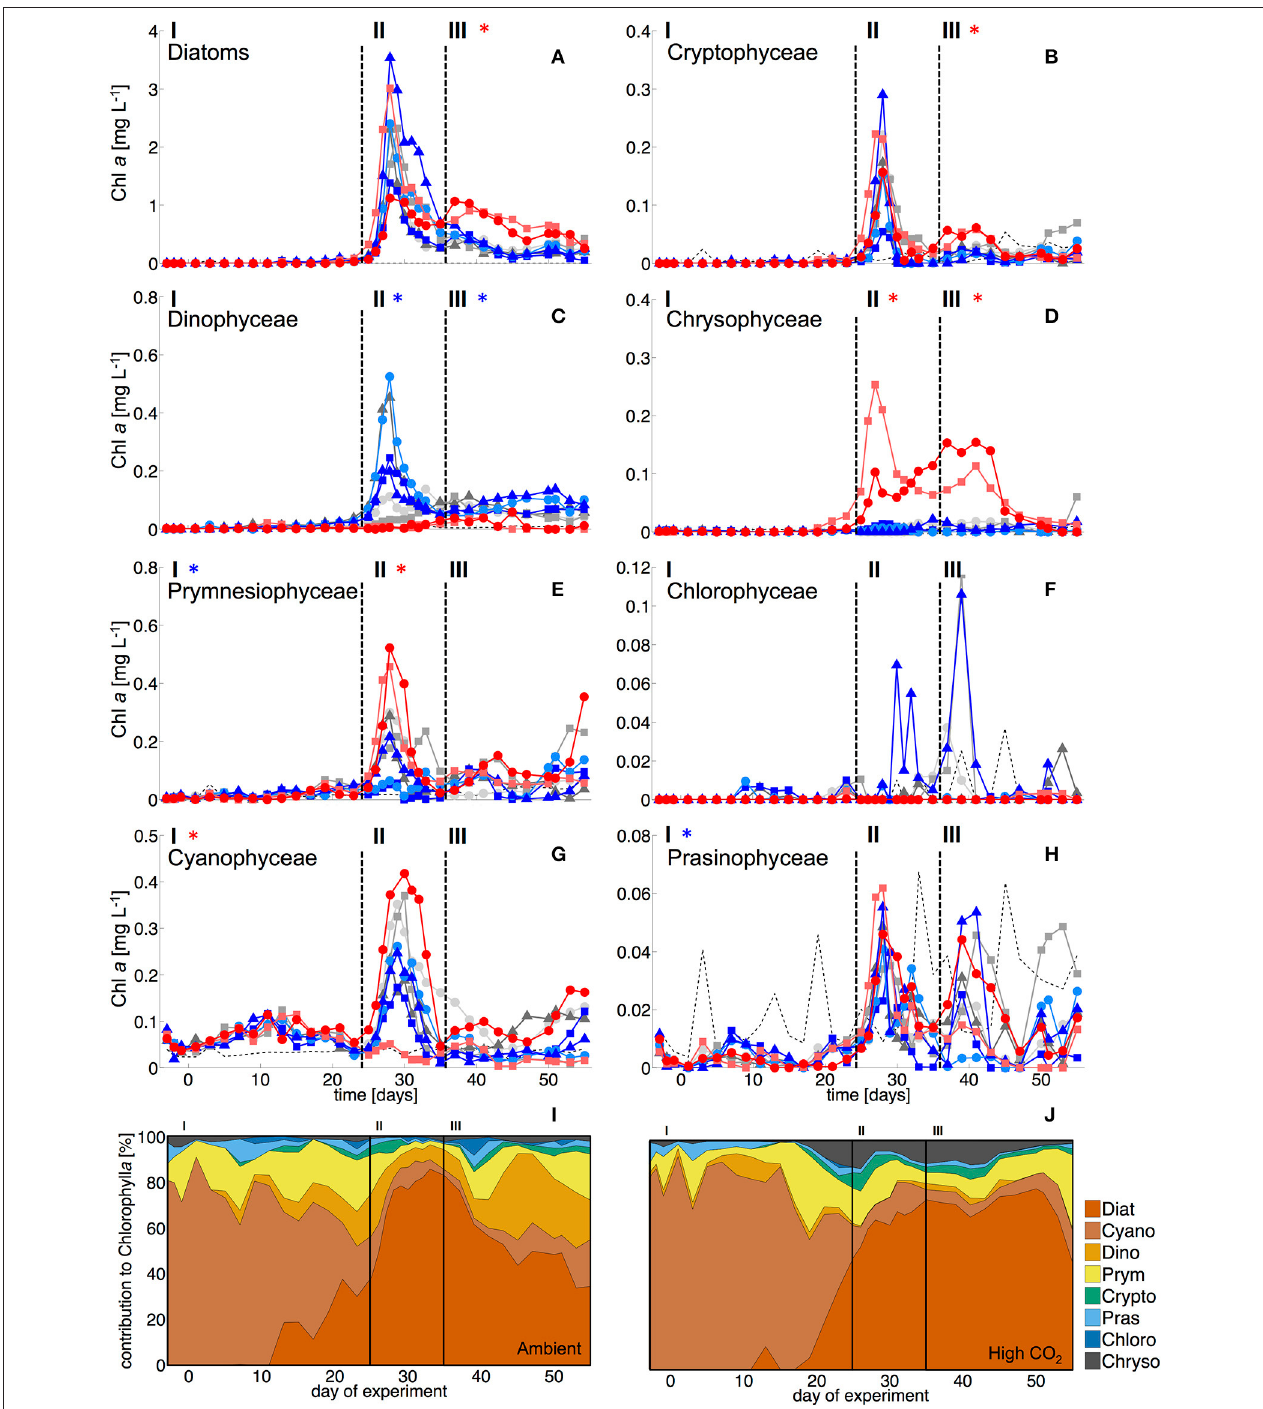
FIGURE 2 | Biomass of phytoplankton groups based on pigment analysis and CHEMTAX. Dashed vertical lines denote different experimental phases (I-III, see section Methods). (A) Diatoms, (B) Cryptophyceae, (C) Dinophyceae, (D) Chrysophyceae (mainly reflecting the signal of the Dictyochophycea Vicicitus globosus), (E) Prymnesiophyceae (mostly Phaeocystis globosus), (F) Chlorophyceae, (G) Cyanophyceae (mostly Synechococcus), and (H) Prasinophyceae. Asterisks denote statistically significant effect of CO 2 during this phase (red = positive, blue = negative). (I, J) Relative composition of total phytoplankton chl a under (I) ambient CO 2 (M1, M9) and (J) in the high CO2 mesocosms (M2, M8).